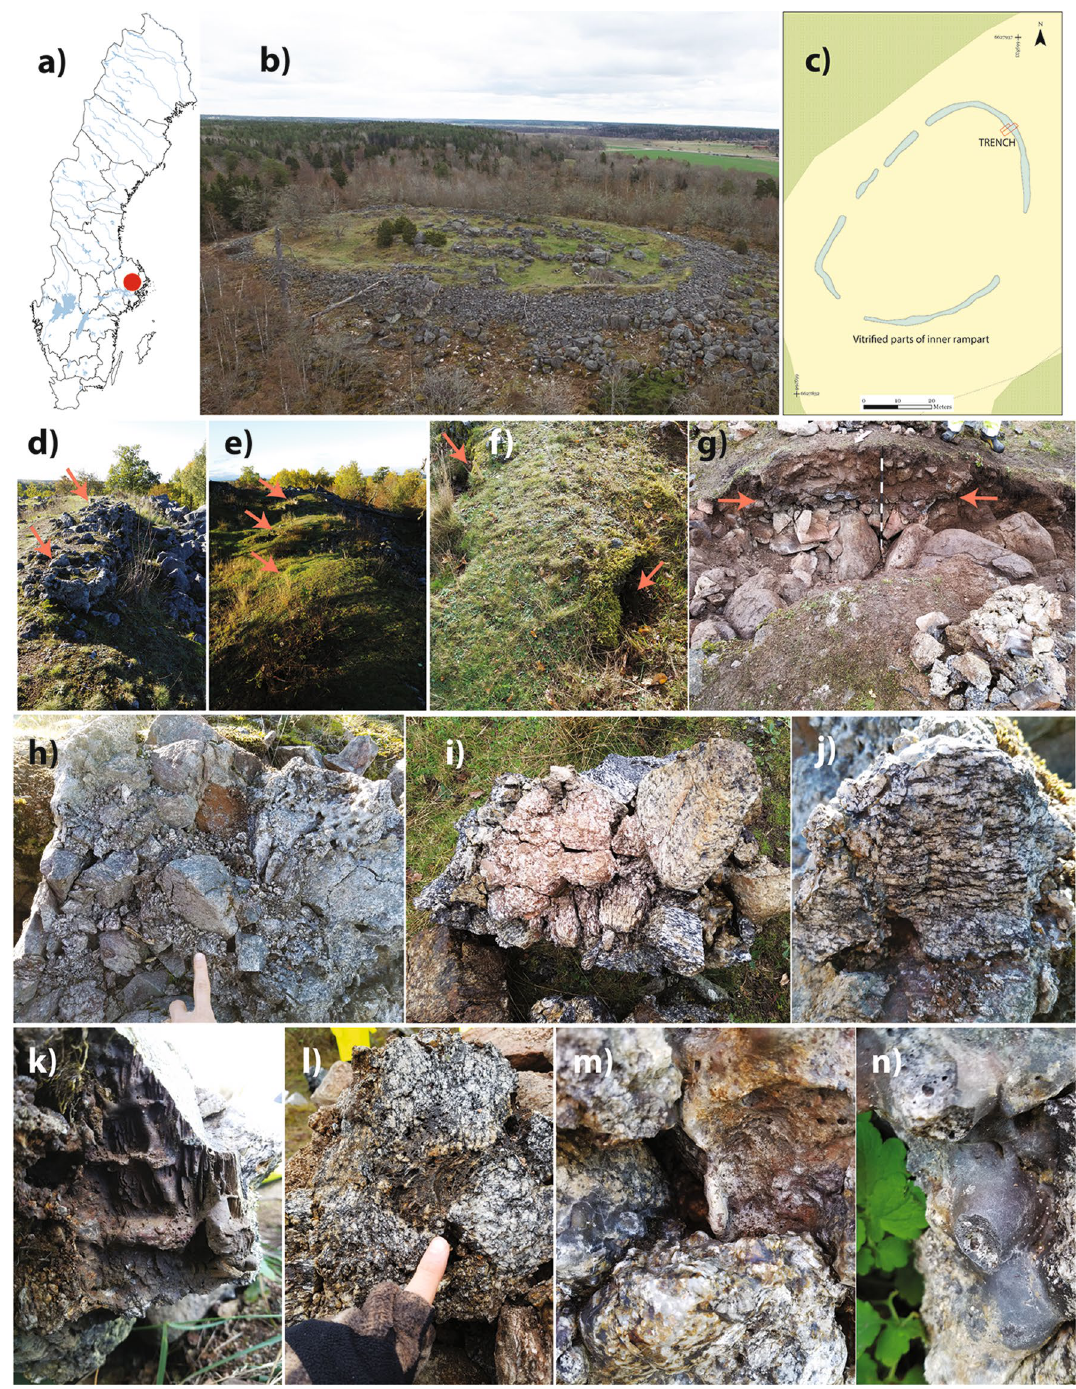
Figure 1. Broborg vitrified hillfort site: ( a ) location of the site within Sweden; ( b ) aerial view looking east; ( c ) plan map of the vitrified inner walls at the summit; d) ‘box-like’ construction on surface; ( e ) ‘box-like’ construction sub-surface; ( f ) ‘box-like’ wall section showing opposite side holes interpreted as used for firing; ( g ) 2017 excavation trench, with arrows showing vitrified portion; ( h ) multiple fused rocks; ( i ) rock with ‘golden biotite’ formed due to heating > 500 °C; ( j ) granitoid with ‘weeping’ dark melt from melted mafic minerals like biotite, indicating > 1000 °C; ( k ) charcoal or wood impressions in ‘dark glass,’ which are c. 2–4 cm on a side; ( l ) hottest part of melted granitoid from wall interior; ( m ) surficial ‘clear glass’; ( n ) amphibolite melt ‘drips’. Maps in ( a ) and ( c ) created using Adobe Illustrator 2019, modified after Englund et al. 34 ; ( b ) from Englund et al. 34 , open access per CC BY 2.5 SE; all other photographs ( d – n ) by J.